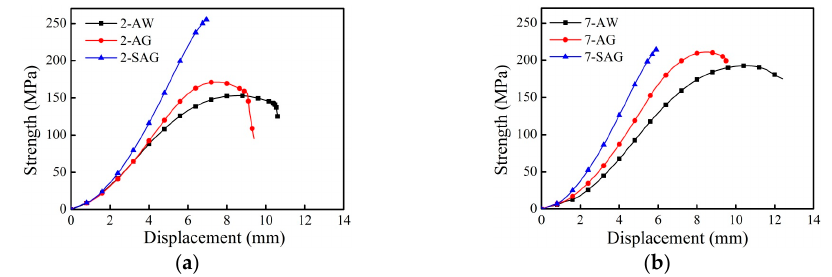
Figure 11. Tensile curves of welded joints after different kinds of PWHTs: ( a ) sample No. 2; ( b ) sample No. 7.